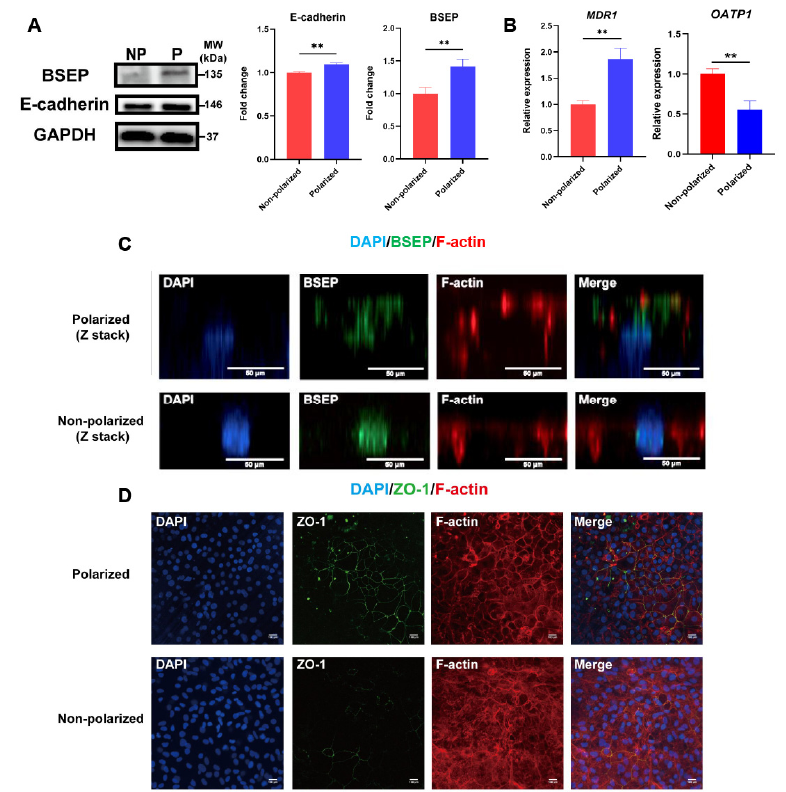
Figure 3. Identification of apical membrane proteins and ZO-1 in the polarized hEHs. ( A ) Western blot analysis of cell lysates from the non-polarized and polarized hEHs for the detection of BSEP and E-cadherin protein expression level (left panel), quantification of these protein levels normalized to GAPDH protein (right panel). Full-length blots were presented in Supplementary Figure S3. ( B ) Quantitative PCR analysis of apical and basal transporter gene (MDR1 and OATP1) in the non- polarized and polarized hEHs. Relative gene expression represented data normalized to GADPH and calibrated to the non-polarized hEHs. ( C ) Immunofluorescence analysis of BSEP (green) and F-actin (red) on the non-polarized and polarized hEHs; the nuclei were stained with DAPI (blue). Scale bars = 50 µ m. ( D ) Immunofluorescence analysis of ZO-1 (green) and F-actin (red) on the non- polarized and polarized hEHs; the nuclei were stained with DAPI (blue). Scale bars = 100 µ m. Data represent the mean ± SD. * p < 0.05, ** p < 0.01, and *** p <